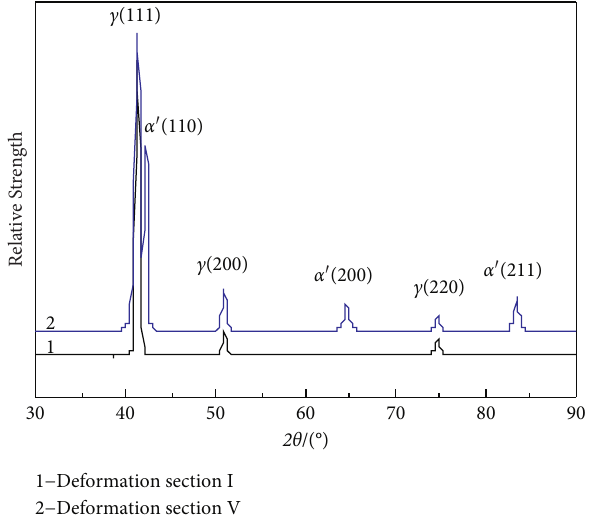
Figure 5: XRD patterns of steel tube before and after